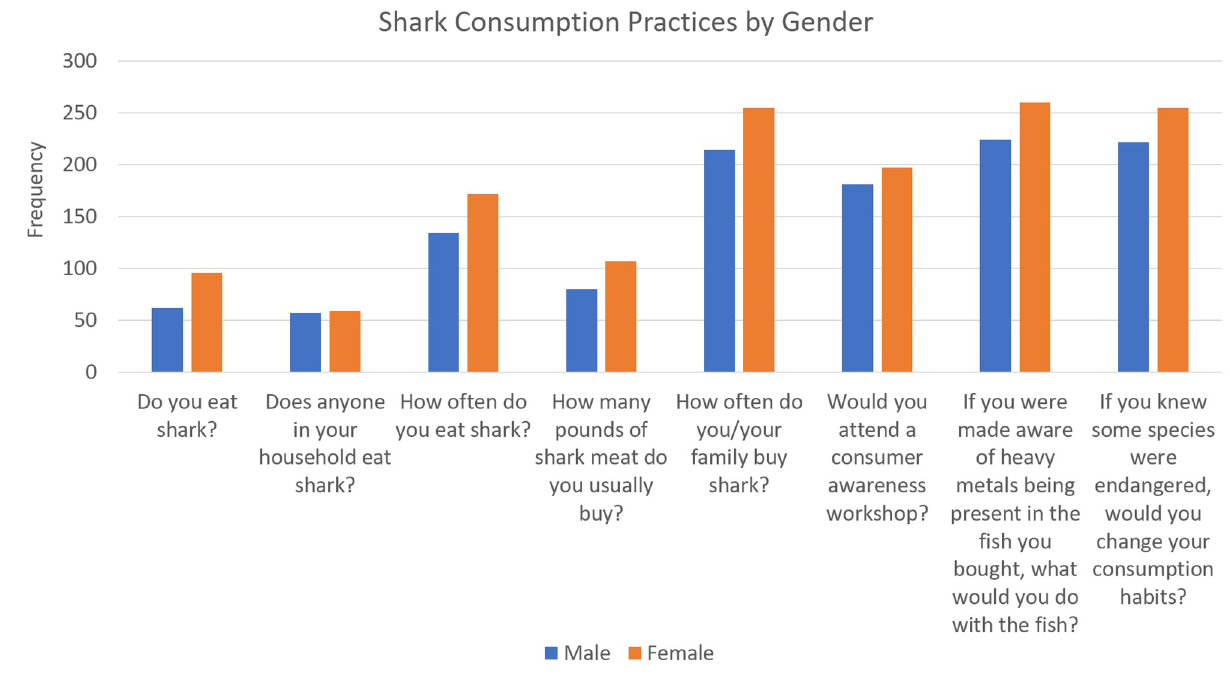
Fig 6. Shark consumption practices by gender.